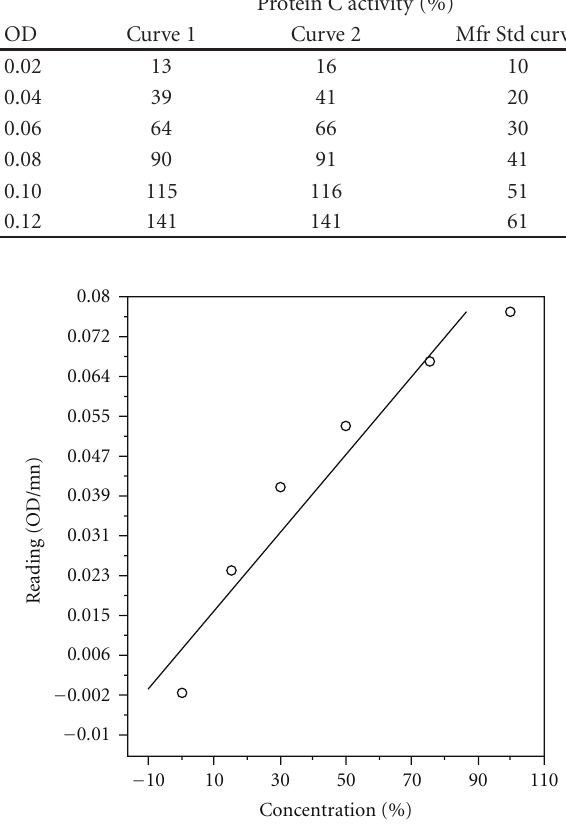
Figure 1: Instrument output for Curve 2. The standard curve was established using the following dilutions of pooled canine plasma (dilution = protein C activity): 1/3 = 100%, 1/4 = 75%, 1/6 = 50%, 1/10 = 30%, 1/20 = 15%, and pure bu ff er = 0%.